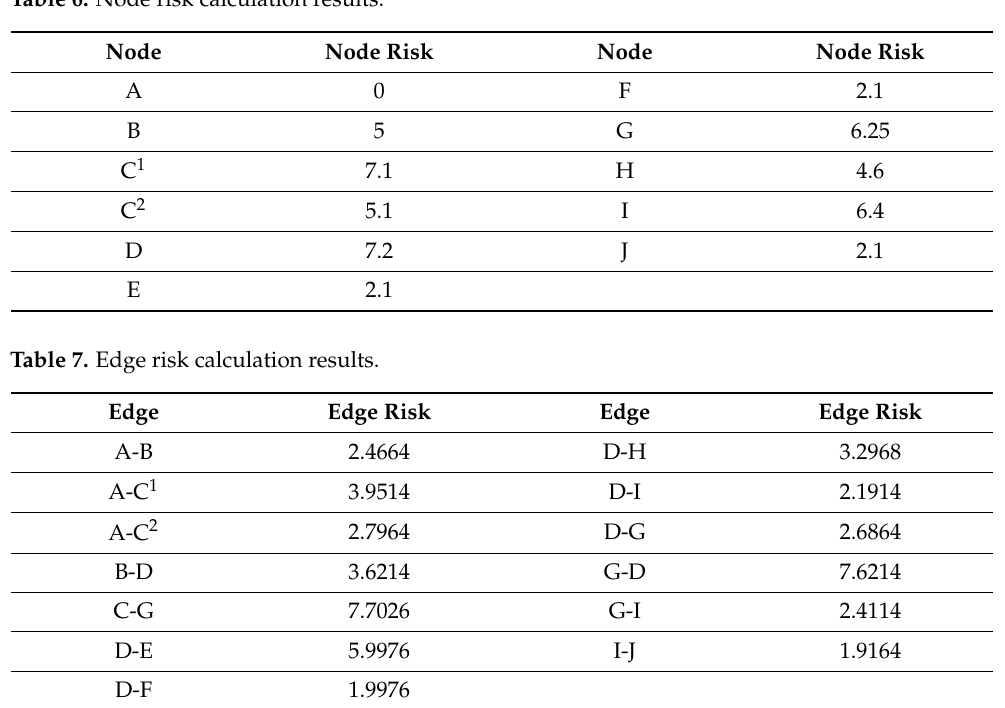
Table 6. Node risk calculation results.